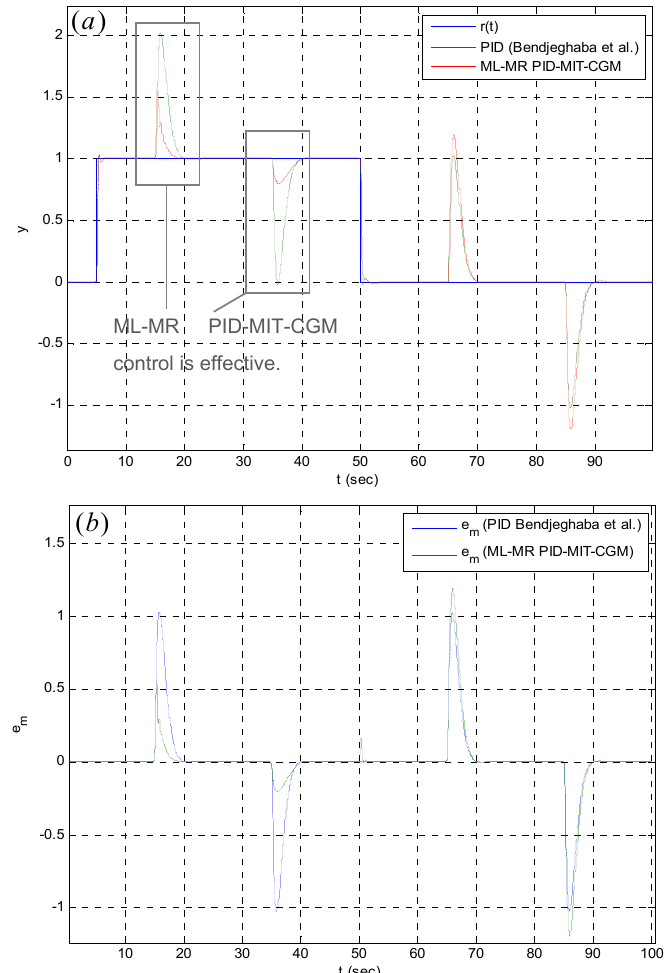
Figure 8. Improvement of the disturbance rejection performance of the classical optimal PID loop by the proposed ML-MR PID-MIT-CGM control structure for the AVR control system model. ( a ) Step response and ( b ) change of model